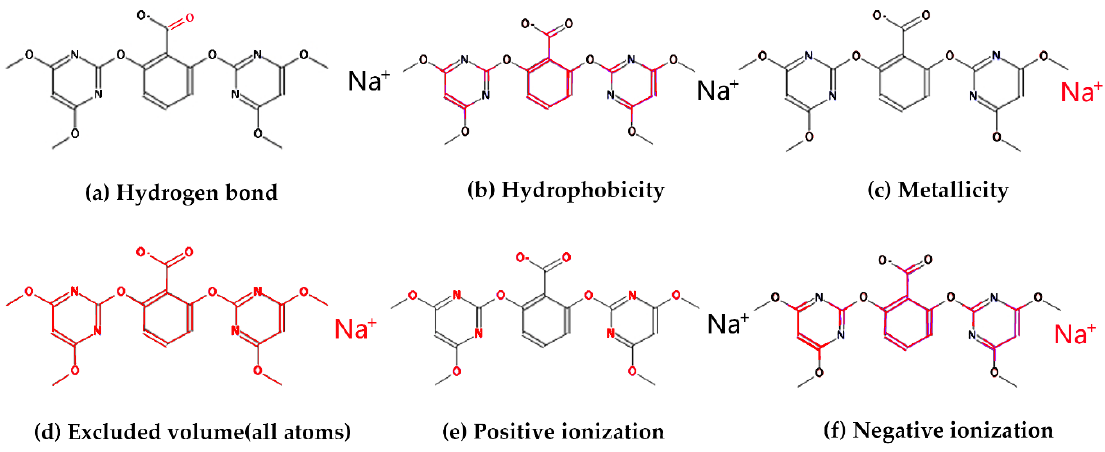
Figure 2. Multi-channel molecular descriptors. ( a ) the descriptor of Hydrogen bond, ( b ) the descriptor of Hydrophobicity, ( c ) the descriptor of Metallicity, ( d ) the descriptor of Excluded volume, ( e ) the descriptor of Positive ionization, ( f ) the descriptor of Negative ionization.